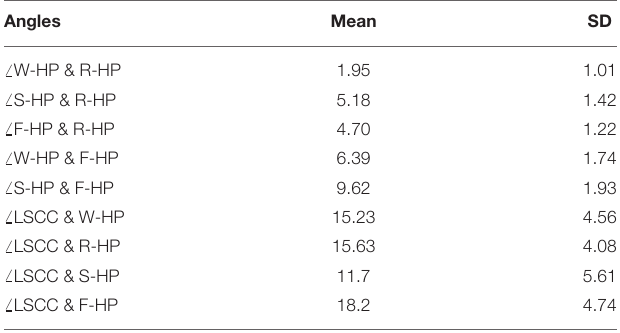
TABLE 2 | Angles (degrees) between the LSCC plane and the horizontal planes of the W–X horizontal plane. Angles Mean